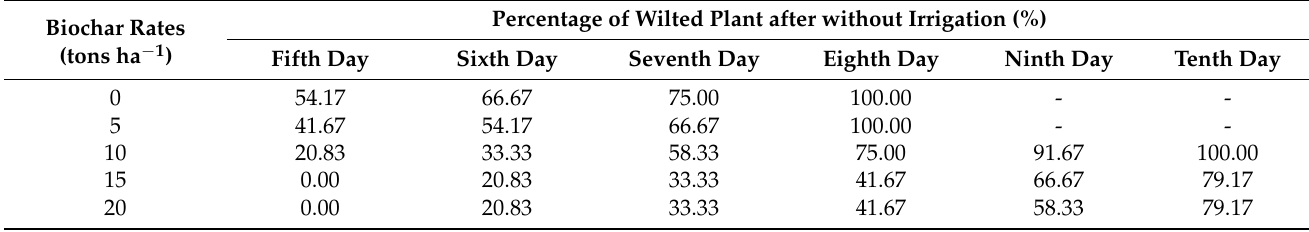
Table 5. Effect of biochar on percentage of wilted plants of Ehretia asperula under WSC. Biochar